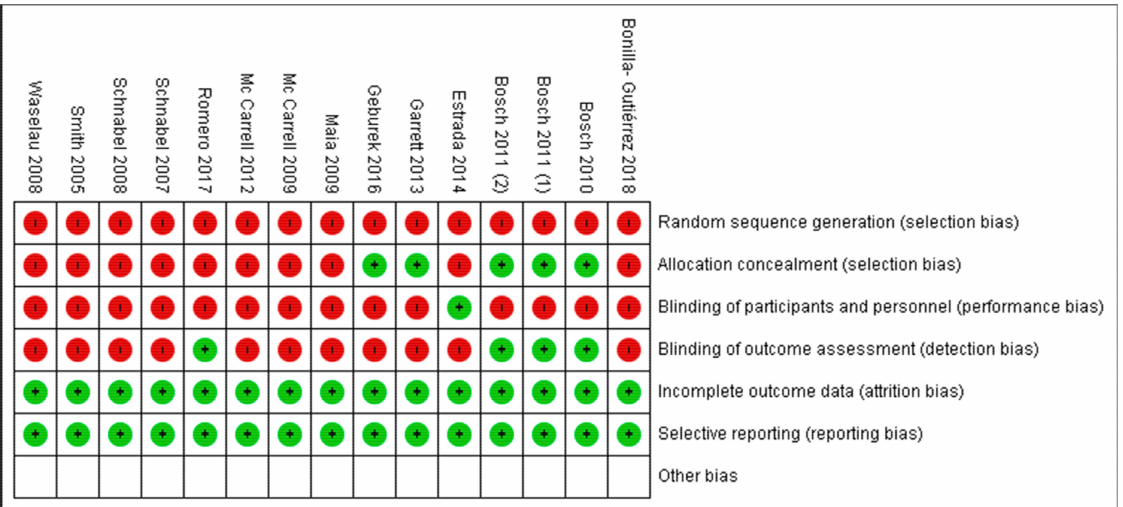
Figure 4. Risk of bias.